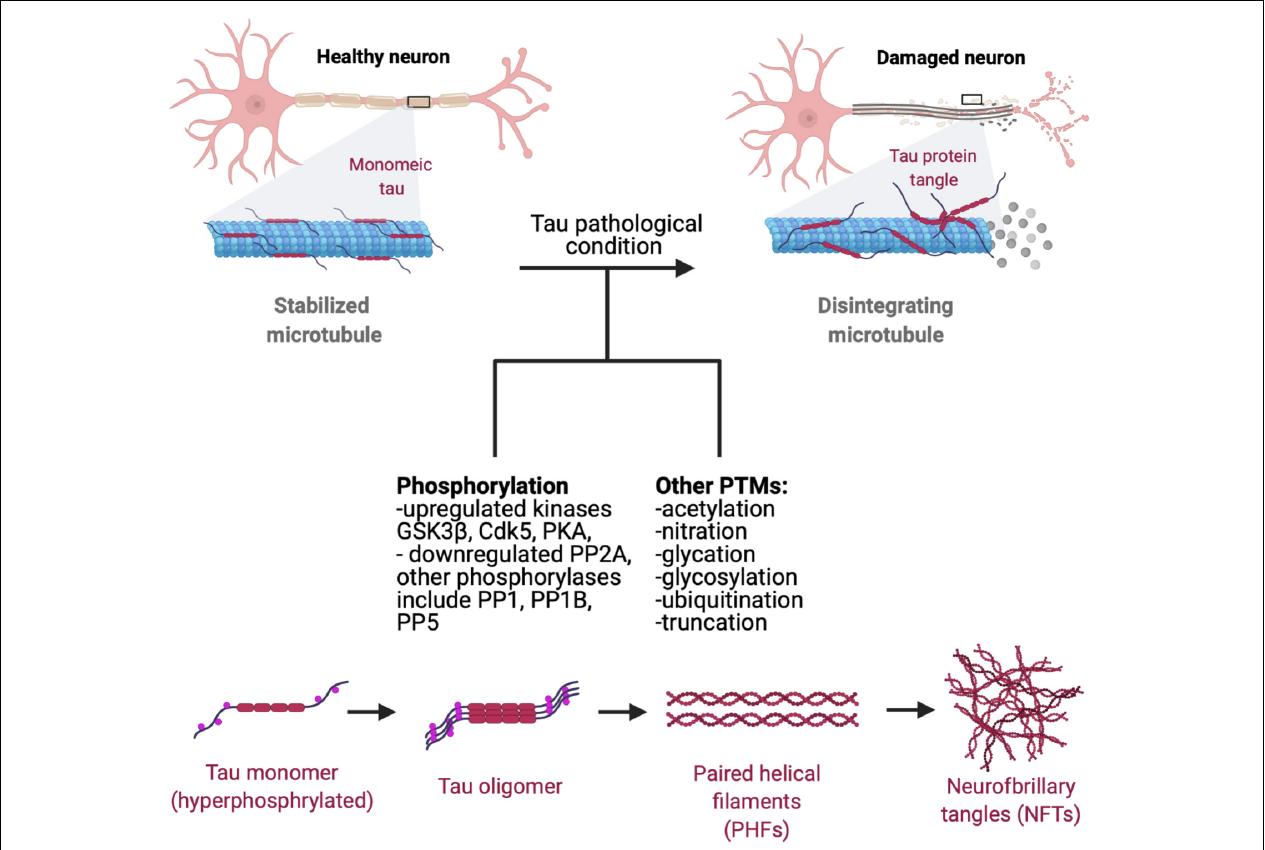
FIGURE 2 | Progression of tau pathology. Microtubules are stabilized by monomeric tau through the MTBR (microtubule binding region). Hyperphosphorylation decreases tau stability and causes p-tau to dissociate from microtubules, leading to disintegration and disruption of normal axonal transport. Hyperphosphorylated tau gains affinity for other tau monomers, forming oligomeric species, adapting a β -sheet structure prior to NFT and aggregate formation (Maeda et al., 2006). Dissociated tau has a tendency to dimerize in an antiparallel fashion, self-assembling into dimers (Wille et al., 1992). These manifest later into PHFs and ultimately NFTs and fibrillar aggregates which can propagate and mediate cytotoxicity in neuronal cells. Phosphorylation of tau by GSK3 β and Cdk5 affects tau-microtubule interactions by reducing tau’s microtubule affinity (Wagner et al., 1996), with protein kinase A (PKA) phosphorylation at S262 and S214 demonstrating similar effects (Biernat et al., 1993; Schneider et al., 1999). Recent studies have also shown that protein phosphatases (PP) PP1, PP2A, PP2B, and PP5 all dephosphorylate tau in vitro , with PP2A functioning as a major regulator of phosphorylation at multiple sites in the brain. PP2A is also partially down-regulated in AD brains in response to tubulin assembly (Sontag et al., 1999; Liu et al., 2005). Tau also goes a plethora of post-translational modifications such as acetylation, nitration, glycation, glycosylation, ubiquitination, and truncation, many of which are known to increase tau’s propensity to aggregate (Alquezar et al.,